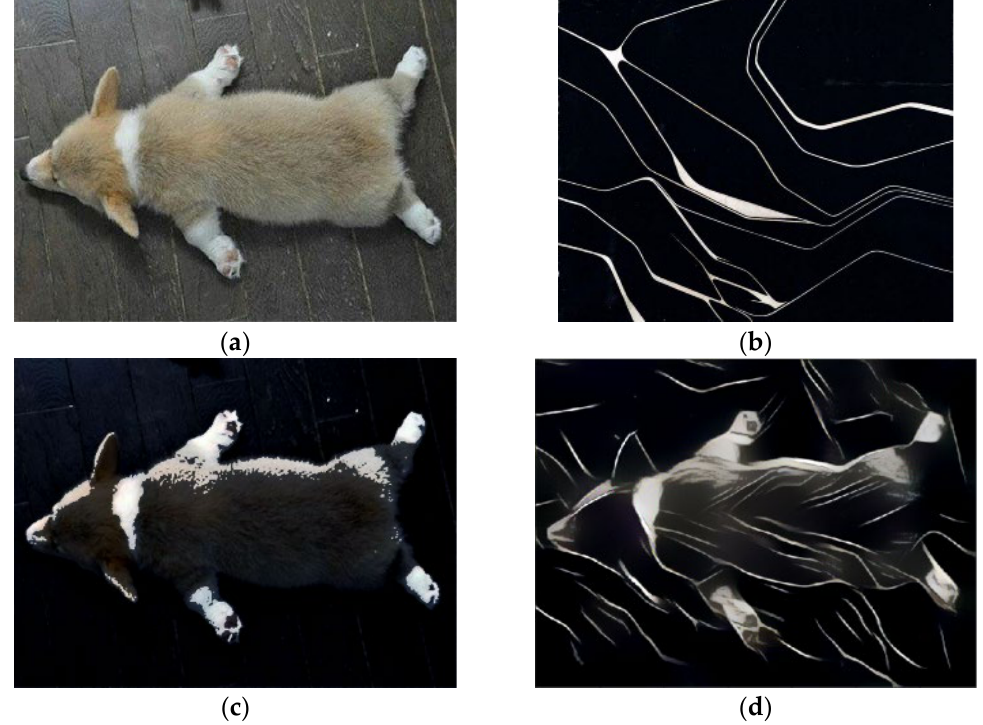
Figure 13. The results of the proposed method image transfer between a wildlife image and an abstract image. ( a ) Content image. From the MS-COCO dataset [26]. ( b ) Target image. From the WikiArt database [27]. ( c ) Color-transferred image with adaptive multilevel image color transfer. ( d ) Style-transferred image after ( c ). Style losses computed on conv1_2 , conv2_2 , conv3_2 , conv4_1